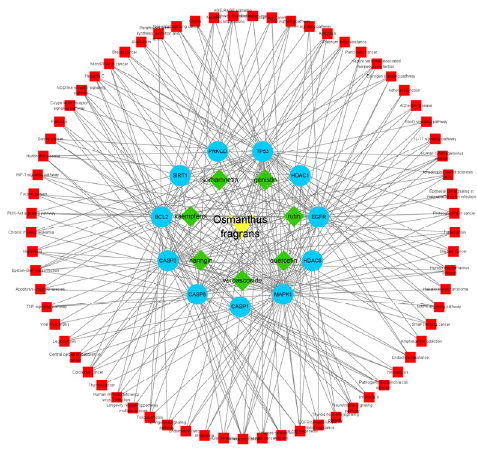
Figure 5. Component–target–pathway. Green: 7 main components of osmanthus extract; blue: 11 overlapping genes; red: all KEGG signaling pathways.